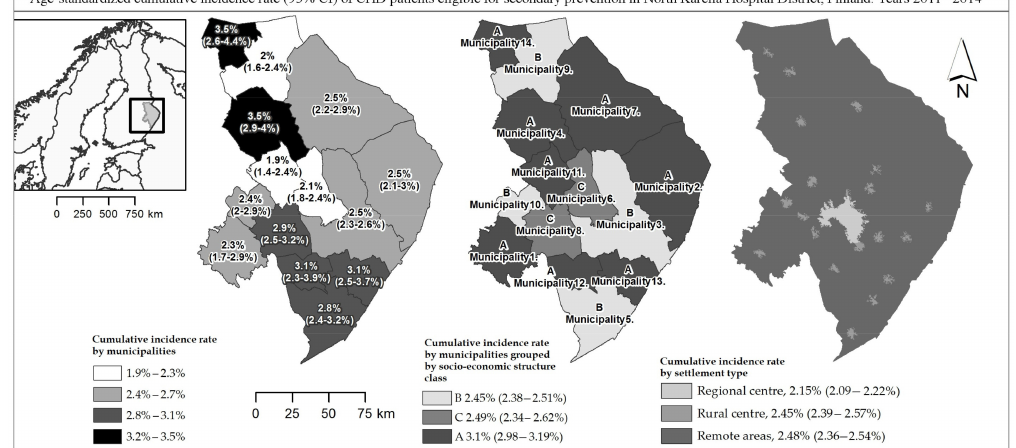
Figure 1. Age-adjusted four year cumulative incidence rate of acute coronary heart disease